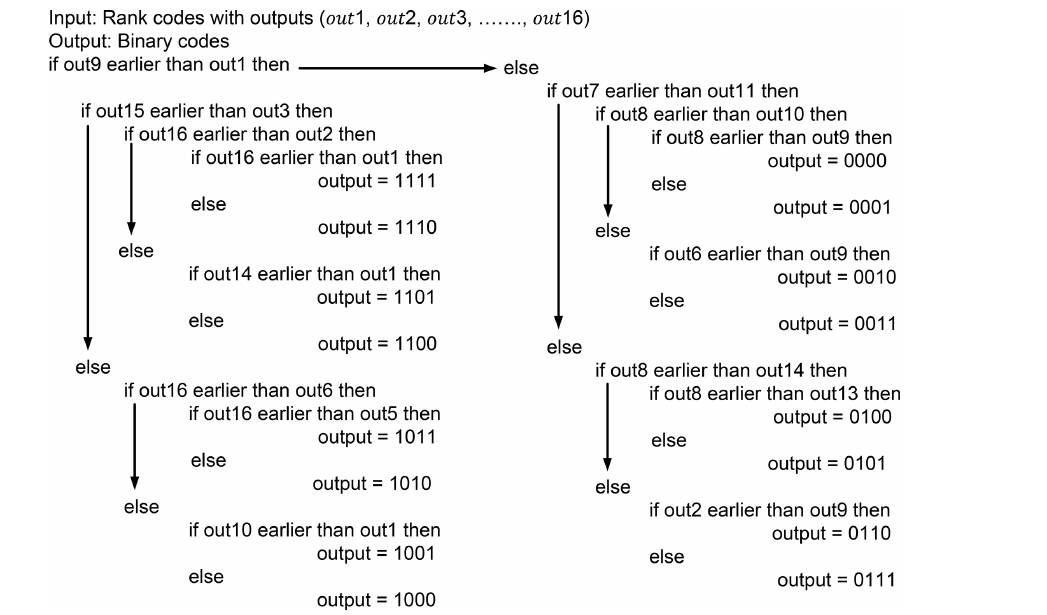
Figure 24. Algorithm for decoding rank codes. It is used to decode the rank codes to binary codes.